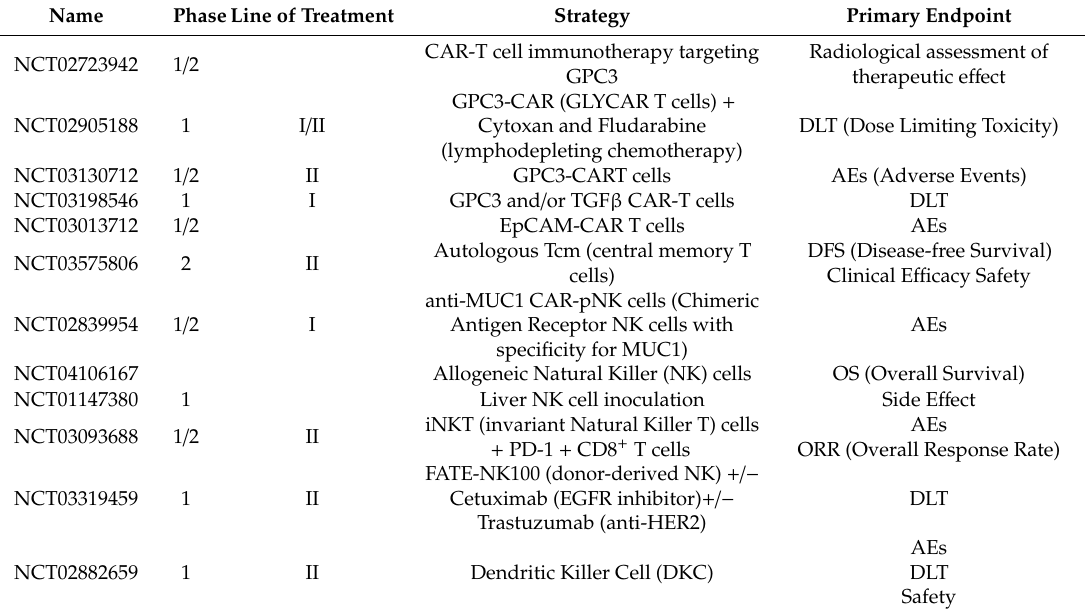
Table 5. Major trials in HCC involving cell-based